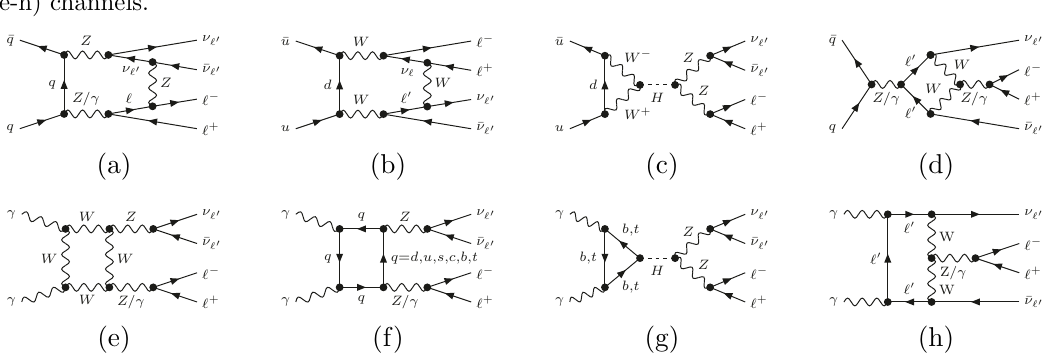
Figure 6 . Sample of one-loop diagrams contributing to 2 ‘ 2 (cid:23) (cid:12)nal states only in the same-(cid:13)avour (wrt. the charged leptons) case in the quark-induced (a-d) and photon-induced (e-h)